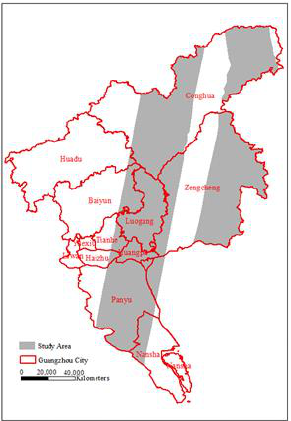
Figure 5. Sketch maps of experimentation area